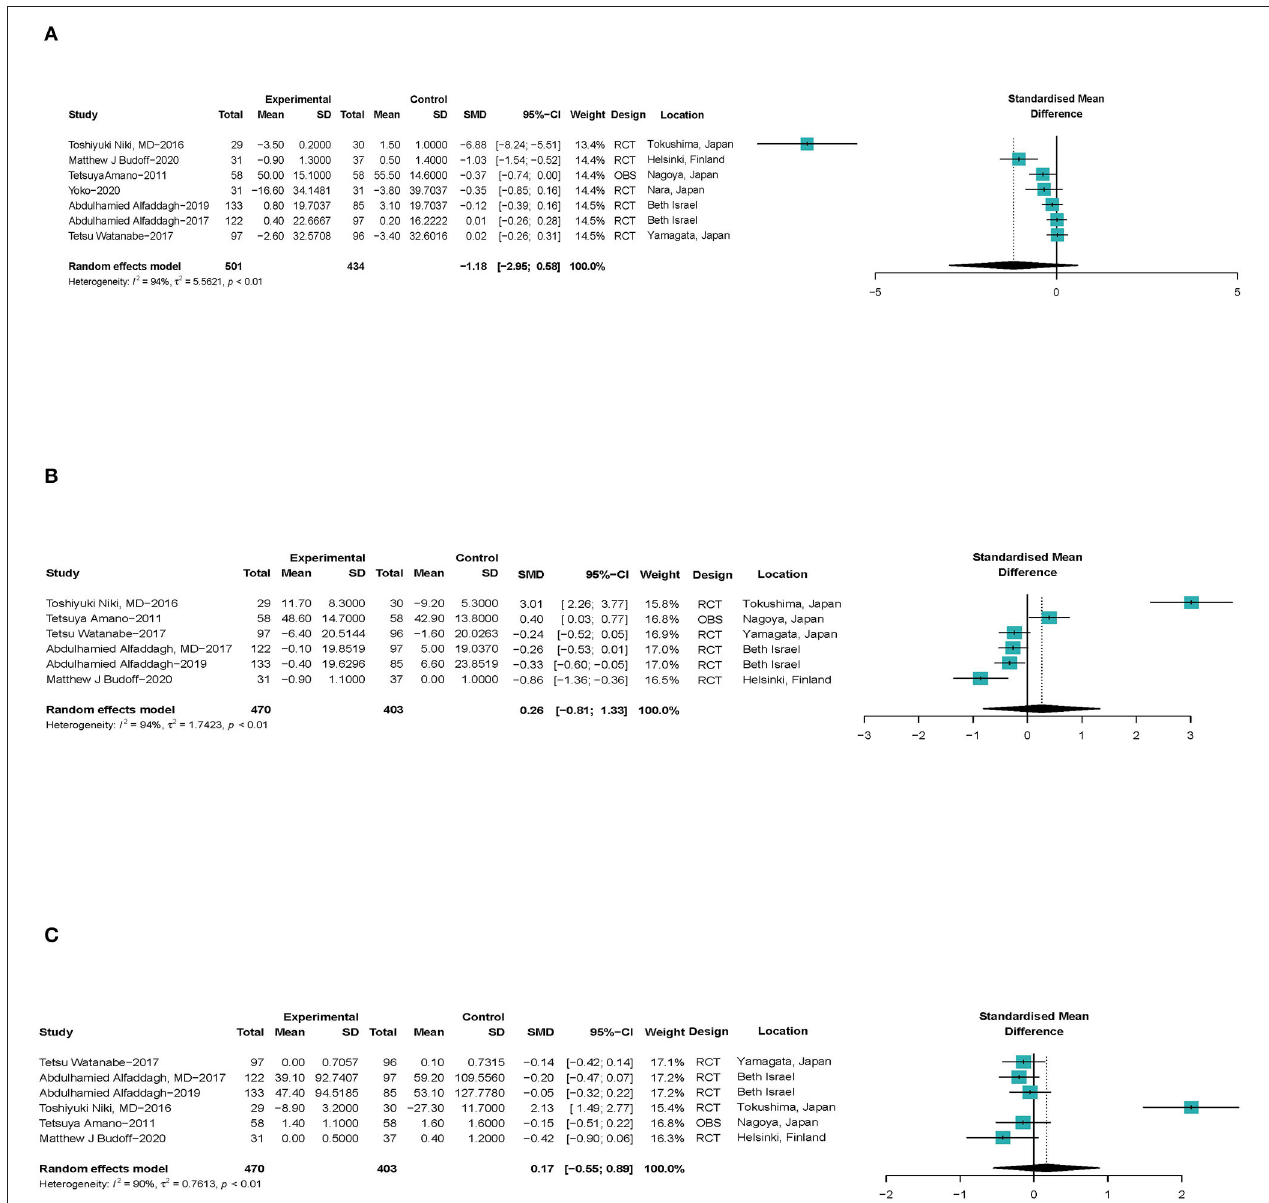
FIGURE 5 | Forest plots of associations of ω -3 PUFAs and coronary atherosclerotic plaque compositions. (A) Lipid plaque volume, (B) fiber plaque volume, and (C) calcified plaque. Point sizes are an inverse function of the precision of the estimates, and bars correspond to 95% CIs. Data are calculated using a random-effect model. RCT, randomized controlled trial; OBS, observational